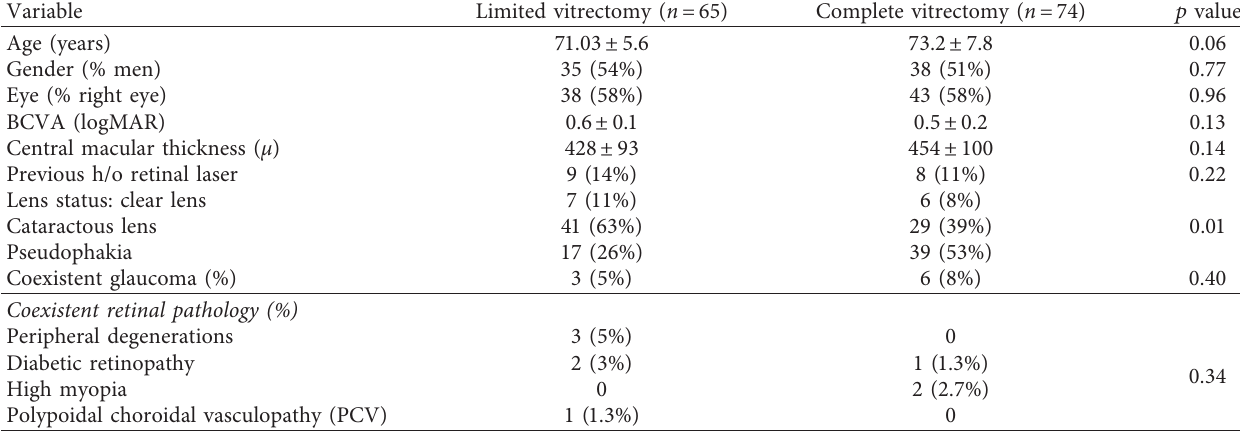
Table 1: Baseline demographic and clinical characteristics of eyes in limited versus complete vitrectomy group.